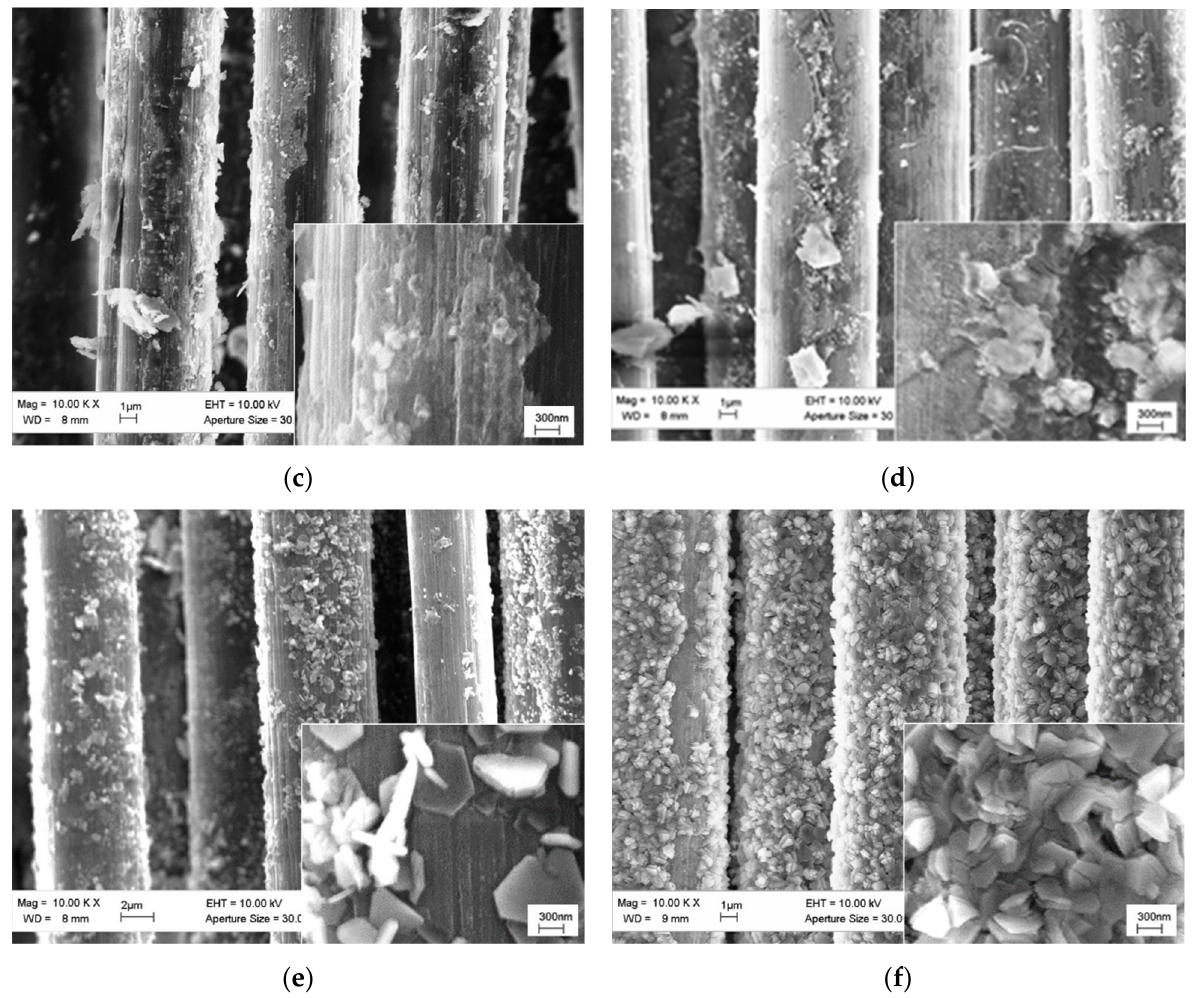
Figure 4. Carbon fiber after the extraction from the matrix of the composite in an initial state ( a ) and subjected to heat treatment at 300 °C ( b ), 400 °C ( c ), 500 °C ( d ), 550 °C ( e ), and 600 °C ( f ). Images include inserts obtained at 50,000× magnification.